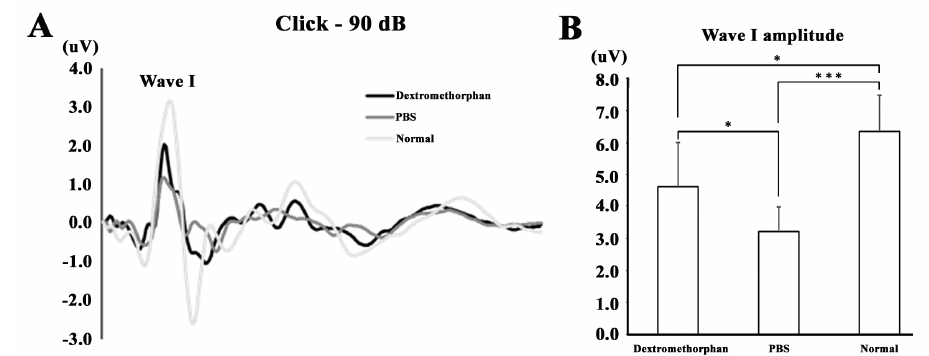
Figure 3. ( A ) ABR waveforms appeared in normal mice without noise exposure, and in the DXM